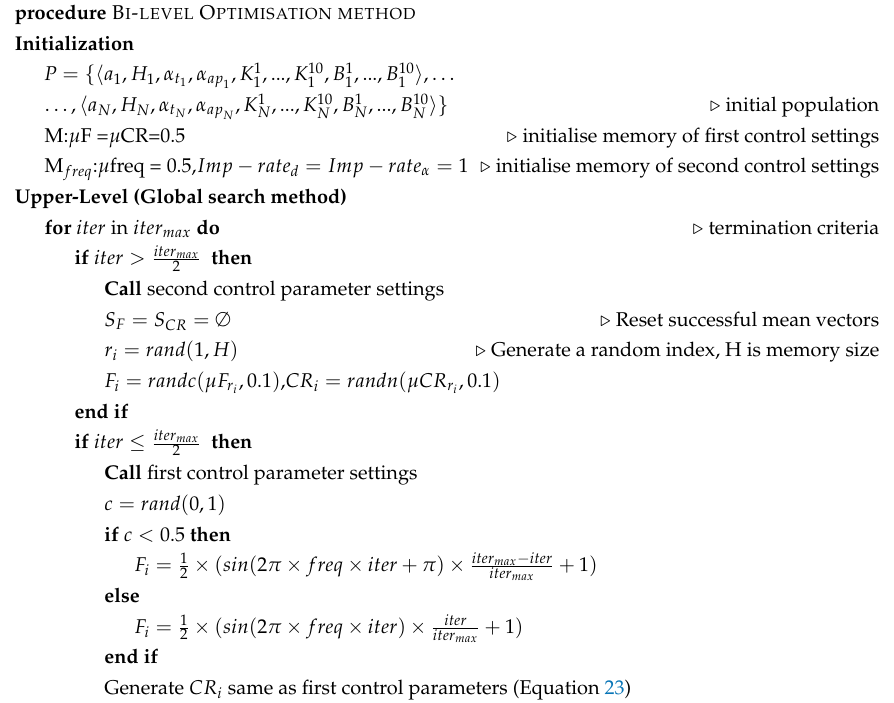
Algorithm 1 Bi-level Optimisation method (LSHADE-EpSin+NM) procedure B I - LEVEL O PTIMISATION